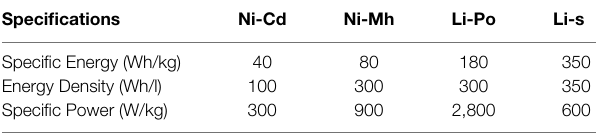
TABLE 4 | Comparison of different batteries specification: specific energy, energy density, and specific power (Hassanalian et al. (2014))